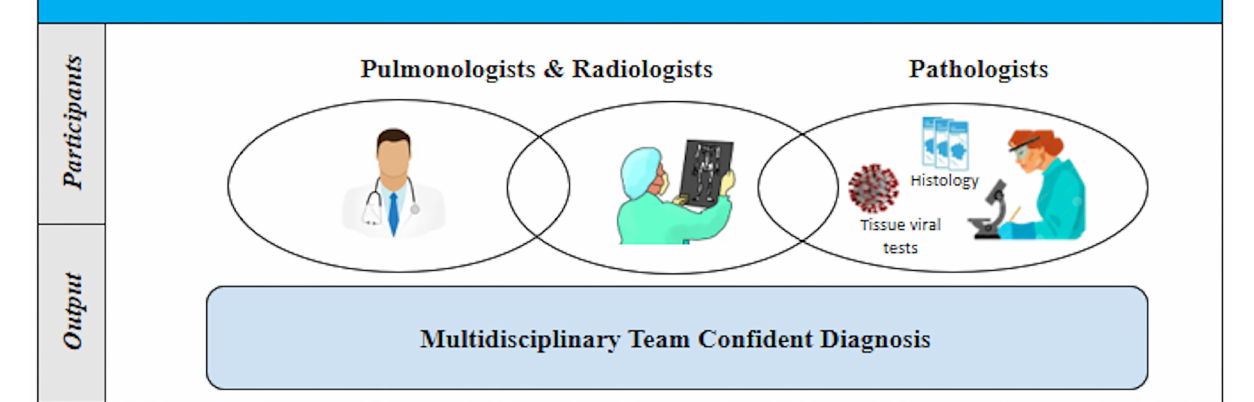
Frontiers in Medicine |